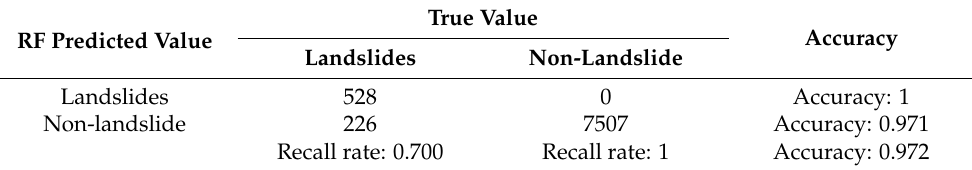
Table 6. Confusion matrix of RF.